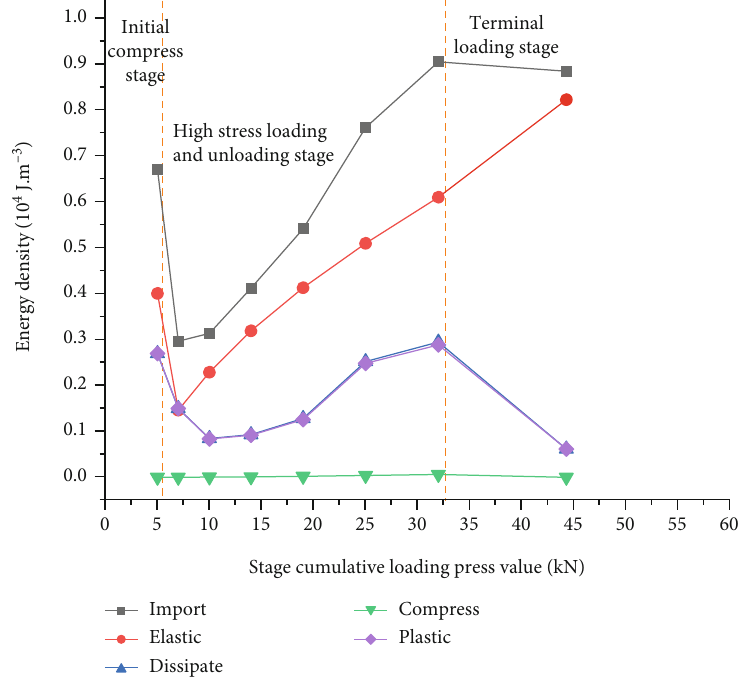
Figure 13: Relationship between energy density and stage cumulative loading press value with sample